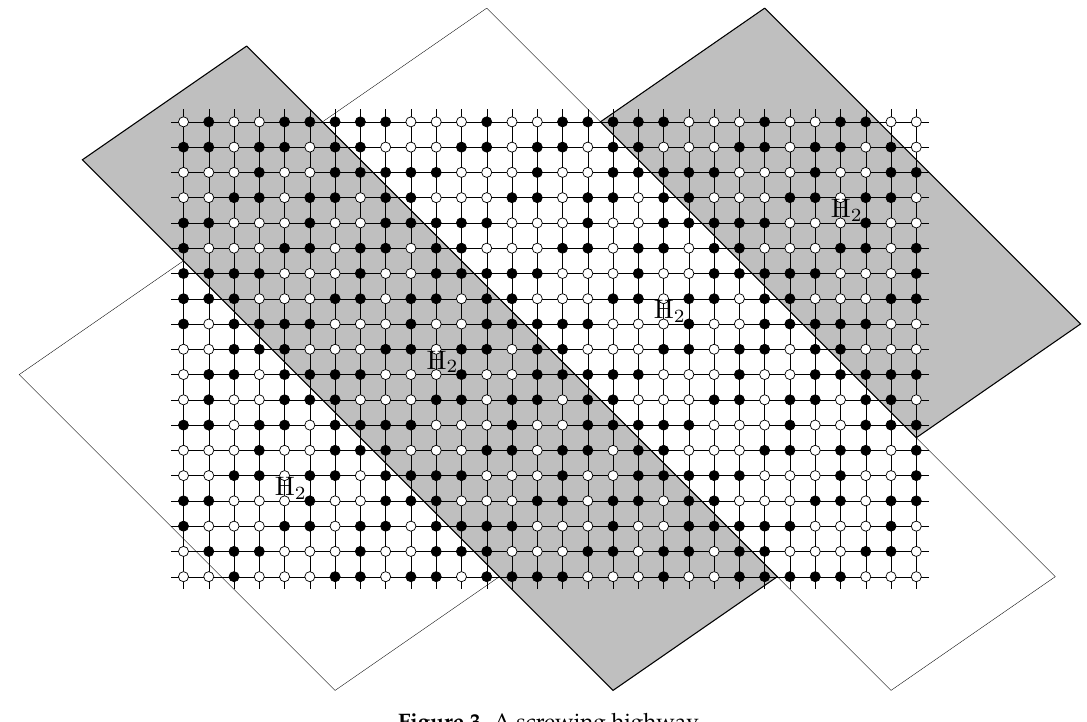
Figure 3. A screwing